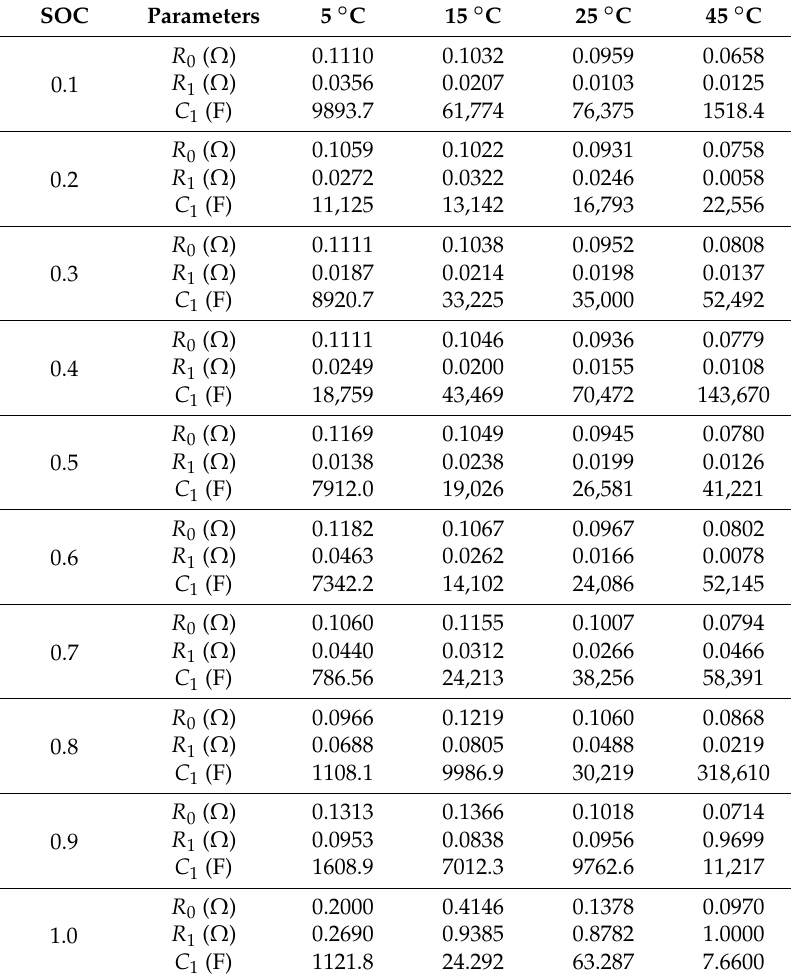
Table 4. Experimental results of R 0 , R 1 and C 1 look-up table for Cell